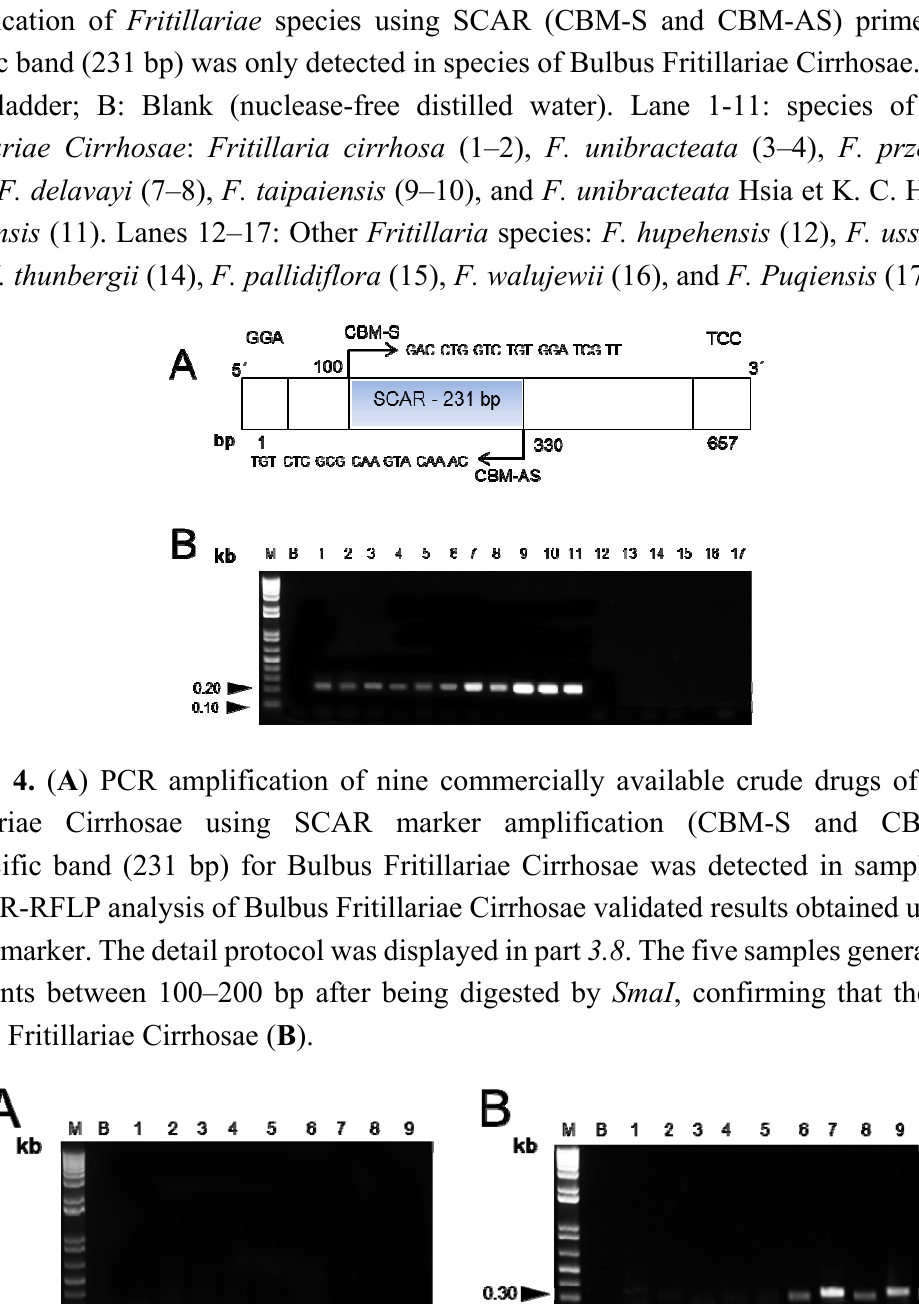
Figure 3. ( A ) Schematic diagram of RAPD and SCAR amplifying region. ( B ) PCR amplification of Fritillariae species using SCAR (CBM-S and CBM-AS) primers. The specific band (231 bp) was only detected in species of Bulbus Fritillariae Cirrhosae. M: 1kb